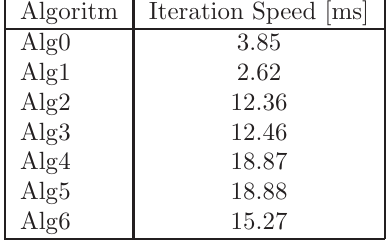
Table 1: Iteration speed of each